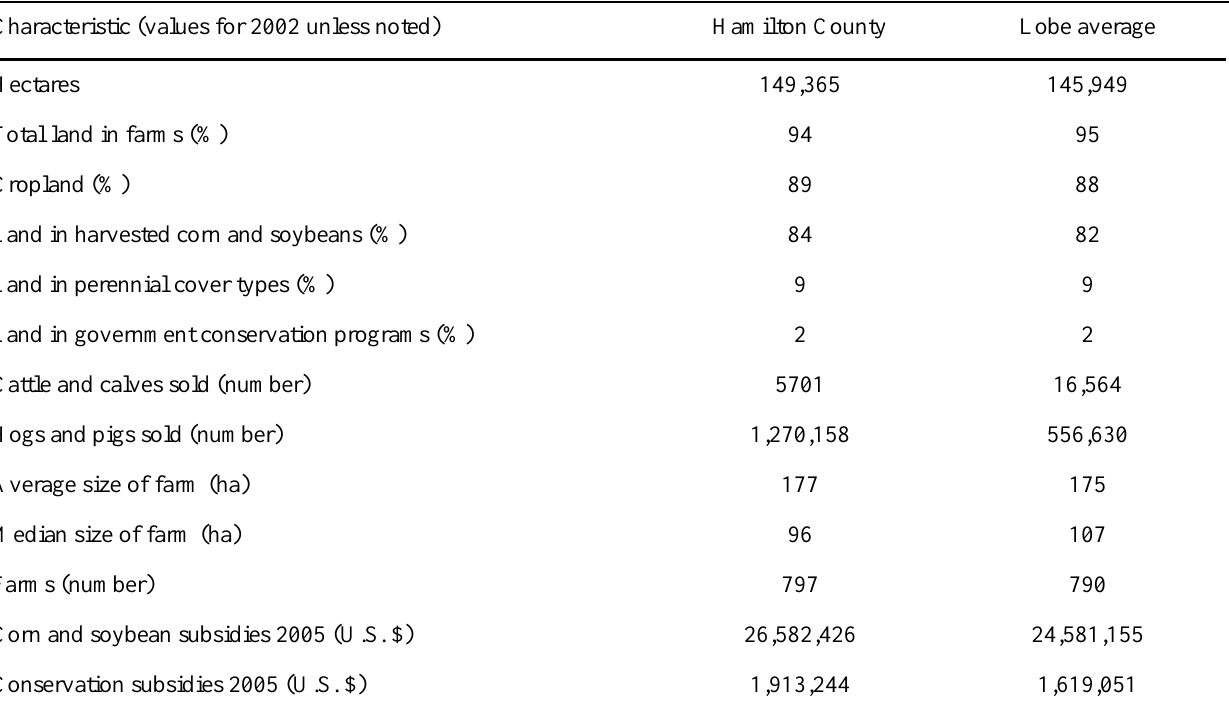
Table 1 . Characteristics of Hamilton County as compared to the average of all 15 Iowa counties located entirely or nearly entirely within the Des Moines Lobe geologic formation (USDA 2002, EWG 2006). Characteristic (values for 2002 unless noted) Hamilton County Lobe average Hectares 149,365 145,949